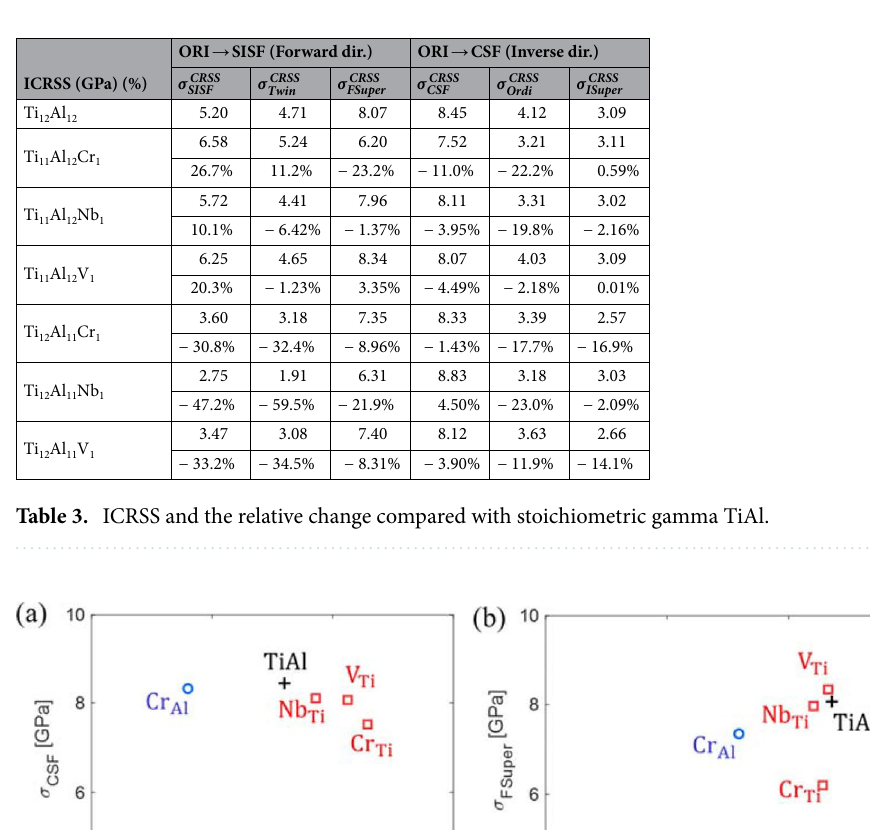
ORI → SISF (Forward dir.) ORI → CSF (Inverse dir.) ICRSS (GPa) (%)